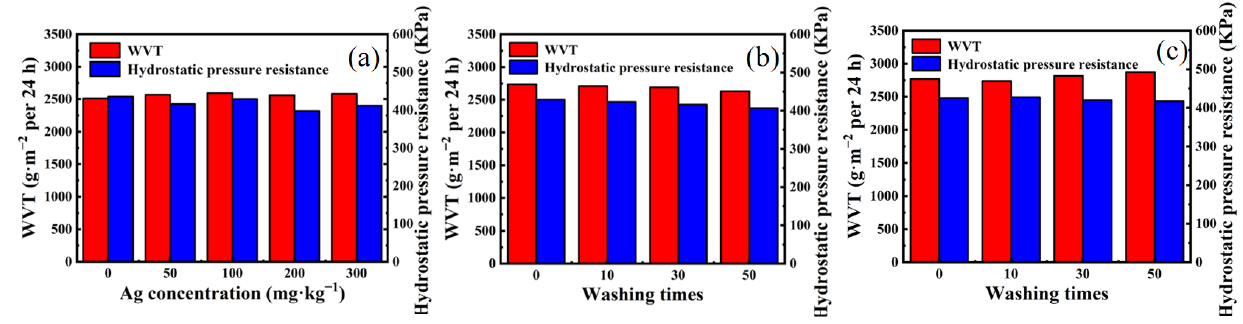
Figure 7. ( a ) Waterproof and moisture permeability properties of TPU nanofiber membrane with Ag content ranging from 0 mg·kg −1 to 300 mg·kg −1 . Waterproof and moisture permeability properties of 100 mg·kg −1 AgNP-embedded TPU nanofiber membrane with 0 – 50 times of ( b ) soaping and ( c ) chlorine washing.